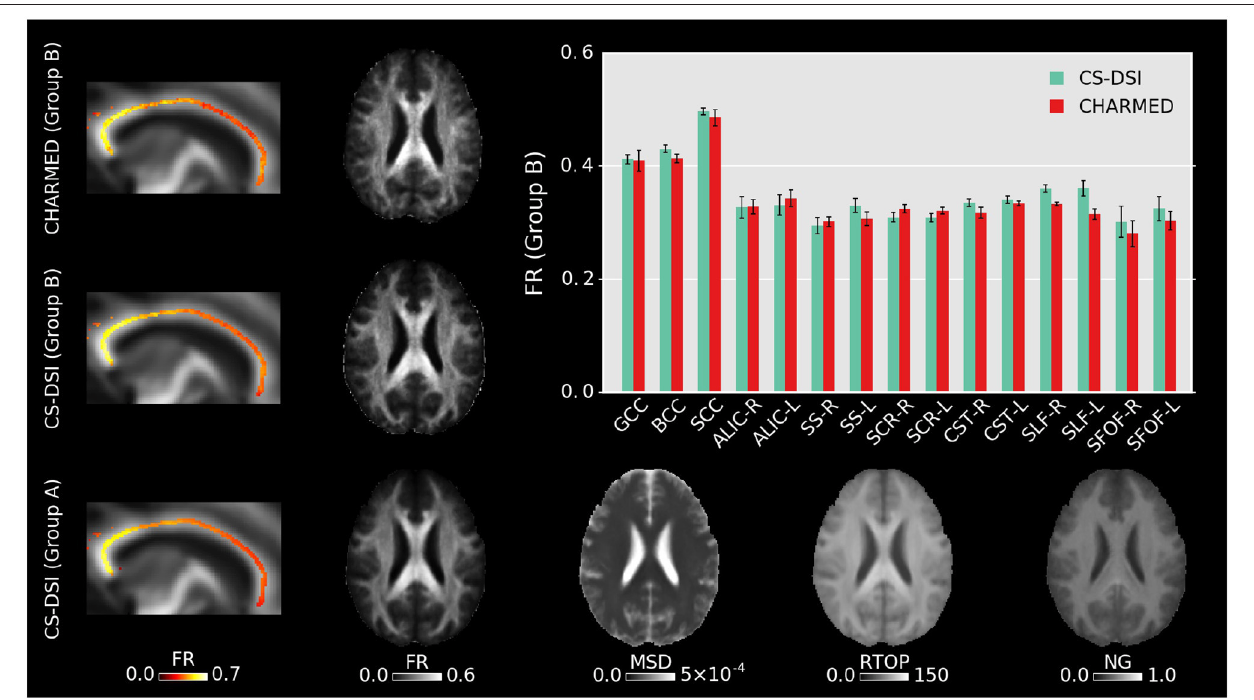
FIGURE 7 | Group averaged whole brain FR maps, FR across the CC skeleton and the FR group mean and standard error across the skeleton within well-known WM ROIs are obtained by fitting the CHARMED model to CS-DSI (Group A and B) and CHARMED (Group B) acquisitions. Both CS-DSI and CHARMED schemes incorporate high b -value acquisitions that allow for accurate CHARMED modeling. For CS-DSI, additional maps of MSD, RTOP, and NG are obtained from the diffusion propagator by means of the MAPL MRI model. MSD and RTOP are given in units of mm 2 and mm − 1 ,